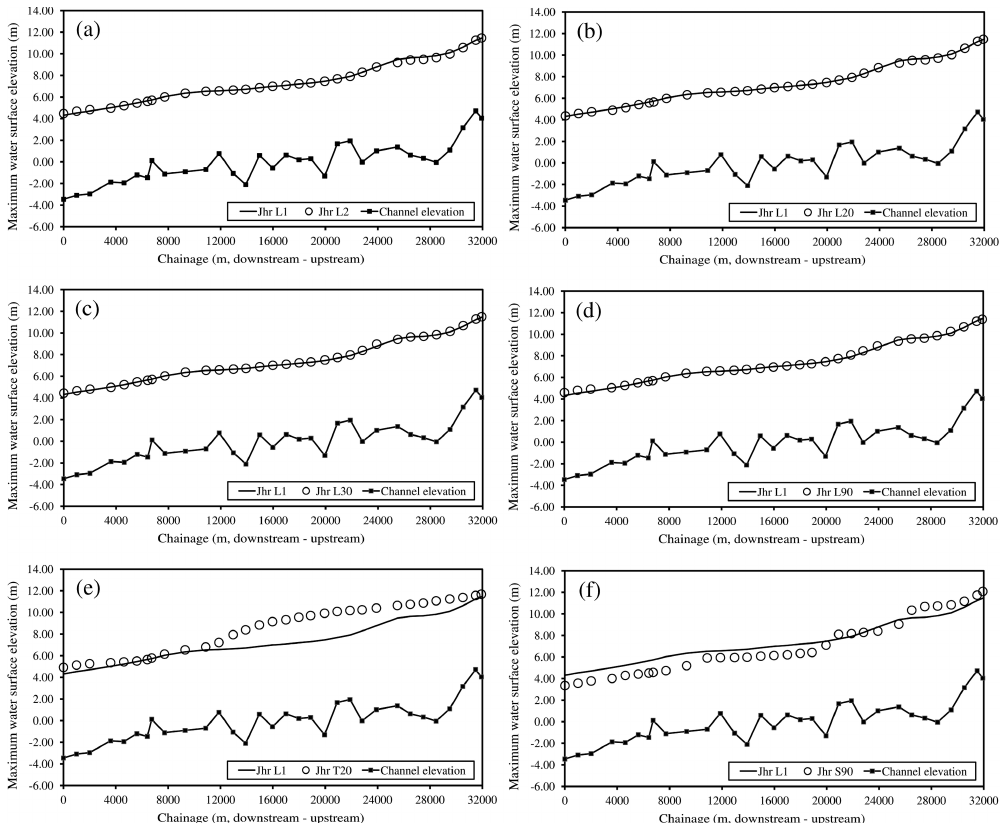
Figure 6. Maximum water surface elevation along the Johor River for the six hydraulic models compared to that simulated by the reference